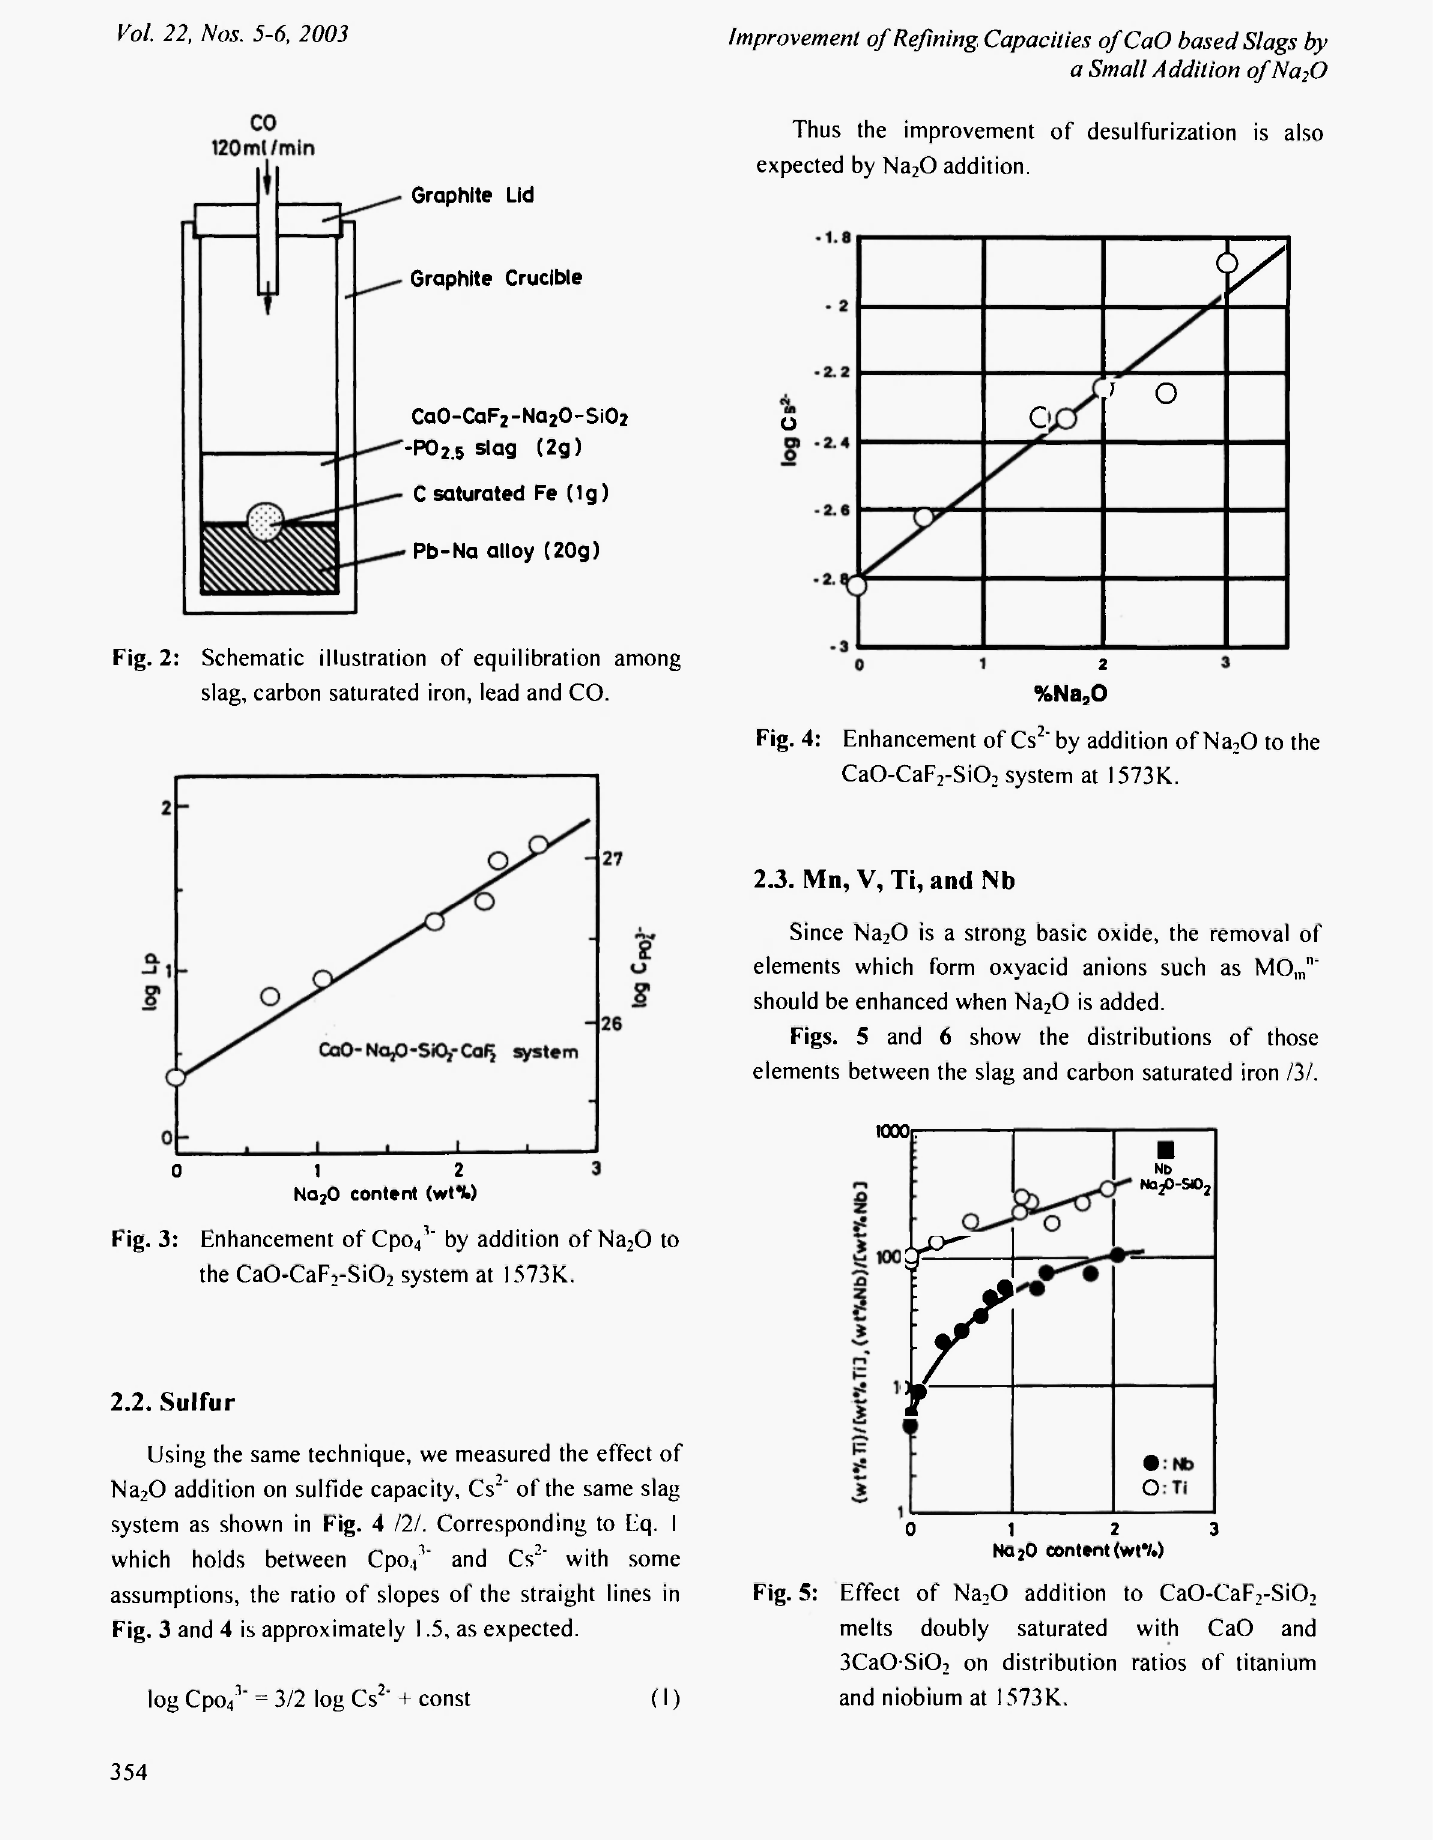
Effect of Na 2 0 addition to Ca0-CaF 2 -Si0 2 melts doubly saturated with CaO and 3Ca0 Si0 2 on distribution ratios of titanium and niobium at